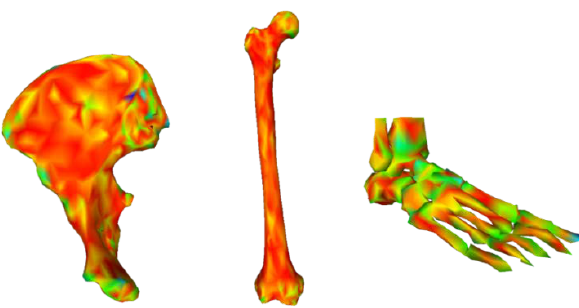
Figure 8. Visual comparison between original and decimated meshes with a red-green-blue scale applying Hausrdoff filter on MeshLab.